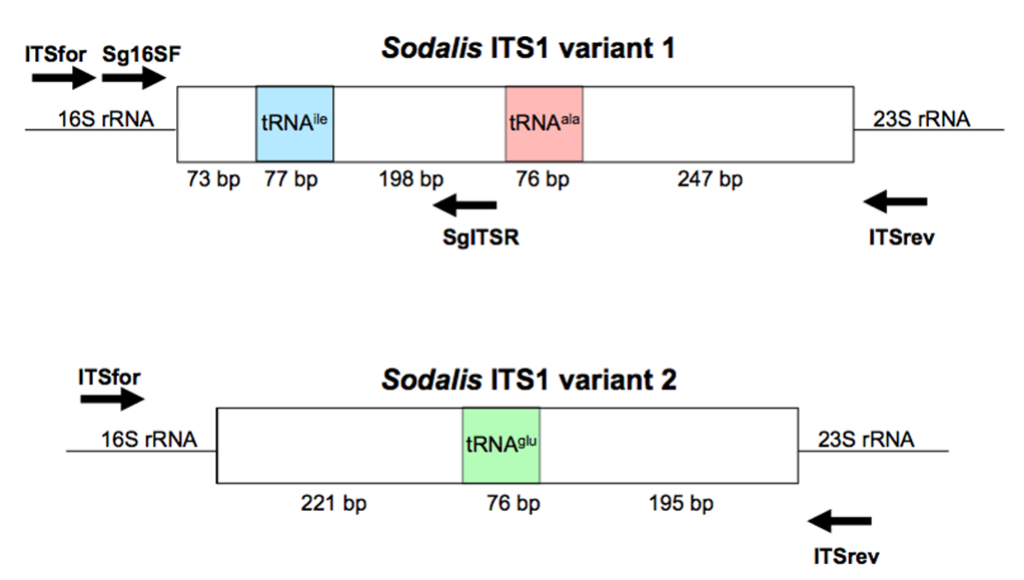
Figure S1. Organization of the two Sodalis ITS1 variants. Locations of the Sodalis -allied symbiont specific PCR primers (Sg16SF and SgITSR) and ITS sequencing primers (ITSfor and ITSrev) are